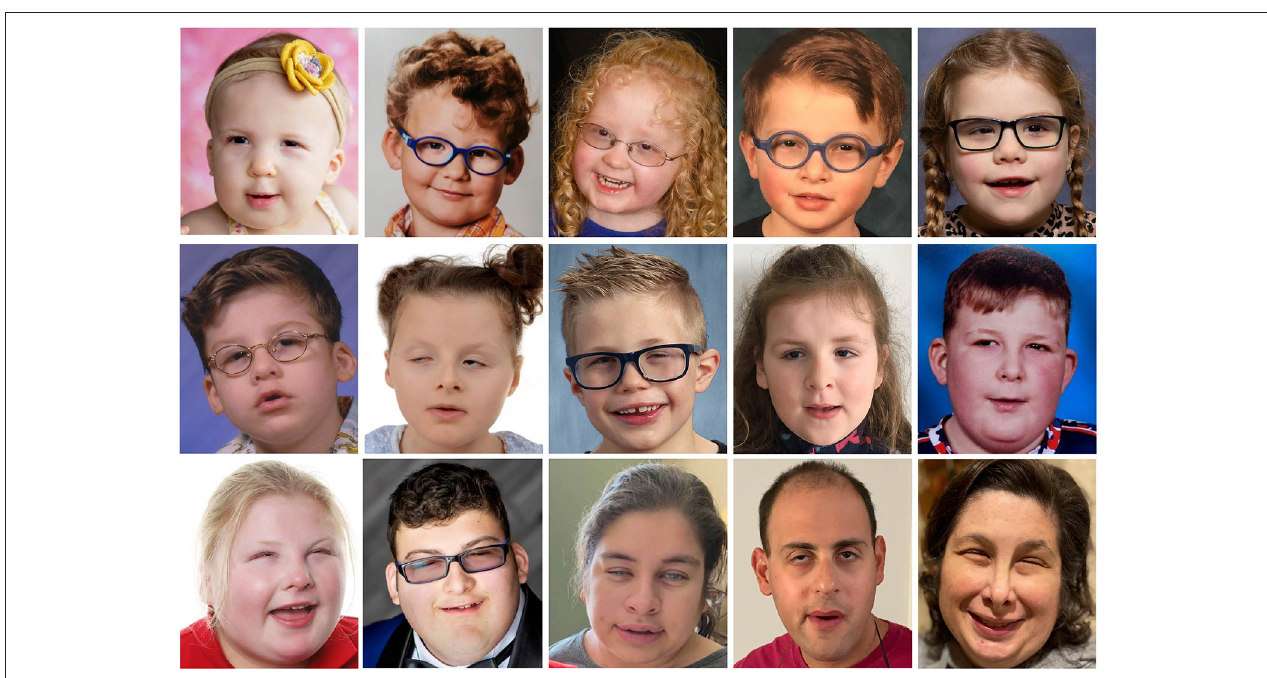
FIGURE 1 | Facial images of individuals with WAGR spectrum. A variety of craniofacial appearances can present in patients, however similar appearances can be appreciated in some. Commonly observed dysmorphic features include low-set ears with abnormal shape; down-slant to palpebral fissures; and prognathism. Strabismus and amblyopia are common in addition to aniridia; and patients frequently wear glasses. Consent for publication was provided by parent or legal representative through the International WAGR Syndrome Association